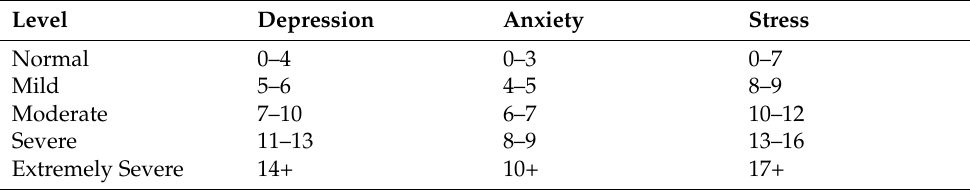
Table 2. DASS21 Ratings for Depression, Anxiety and